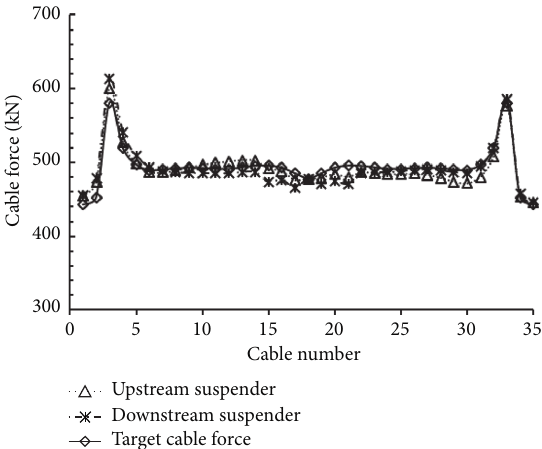
Figure 6: Theoretical and designed suspender tension after